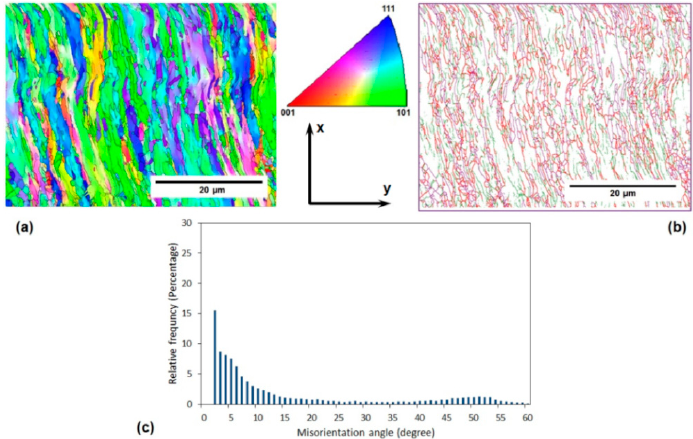
Figure 3. Microstructure features of the annealed AA ‐ 6063 alloy after three passes of MFD process at room temperature (RT): ( a ) the EBSD grain orientation map (IPF map) according to direction 2, ( b ) the EBSD grain boundary map, and ( c ) the misorientation angle distribution diagram.